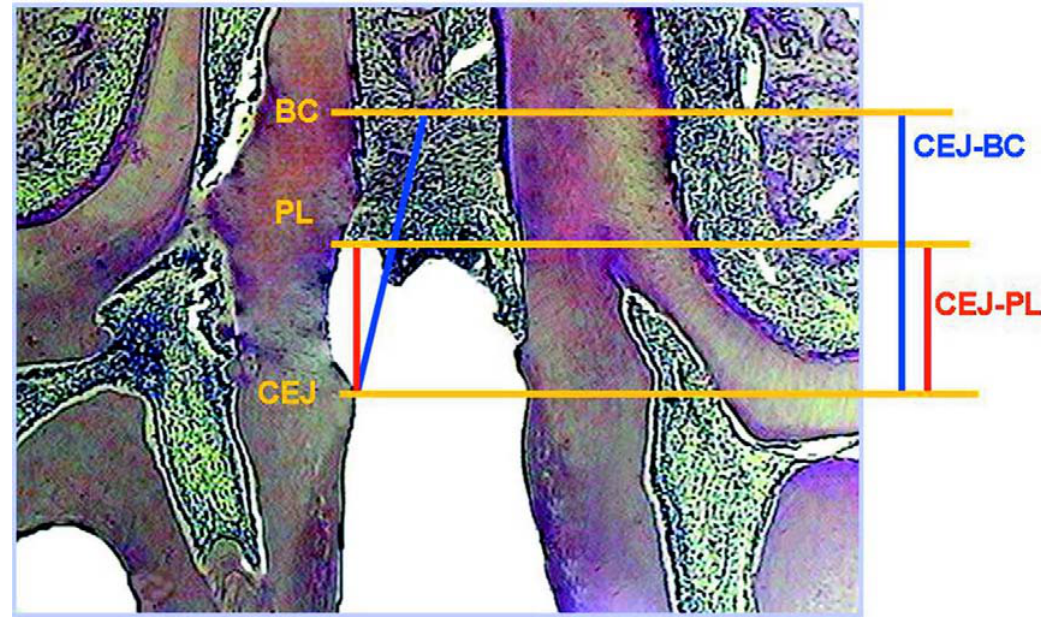
FIGURE 1- Distance between the cementoenamel junction in the mesial side of the 2nd molar and the attached periodontal ligament fibers (CEJ-PL) and distance between the cementoenamel junction and the alveolar bone crest